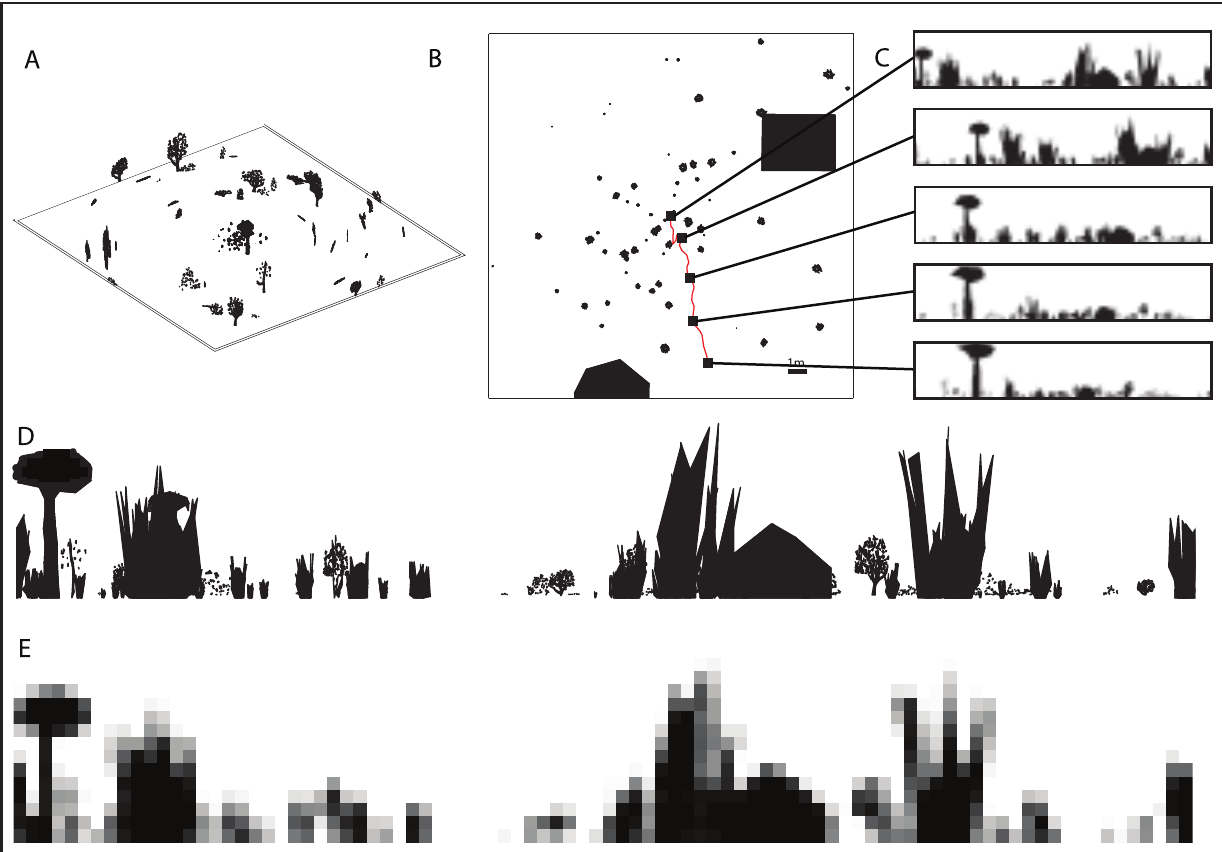
Figure 8. The simulation environment. A,B) Two views of a typical simulated environment used in our experiments. In B the small squares indicate the positions from which the views that are shown in C are taken. C) Five example views taken approximately 2 m apart along a typical route used for learning. The views are oriented so that North (straight up in B) is at the centre of the unwrapped images. D) Typical high-resolution view of the world from an ant’s perspective. E) Low-resolution representation of the view shown in D. doi:10.1371/journal.pcbi.1002336.g008 rescaled to provide variation. The leaves of both the bushes and trees were generated from a base template containing a large number of triangular patches. A subset of these patches was randomly chosen for each tree or bush. The environment used in Figures 4 and 5 contained 50 bushes and trees positioned at a